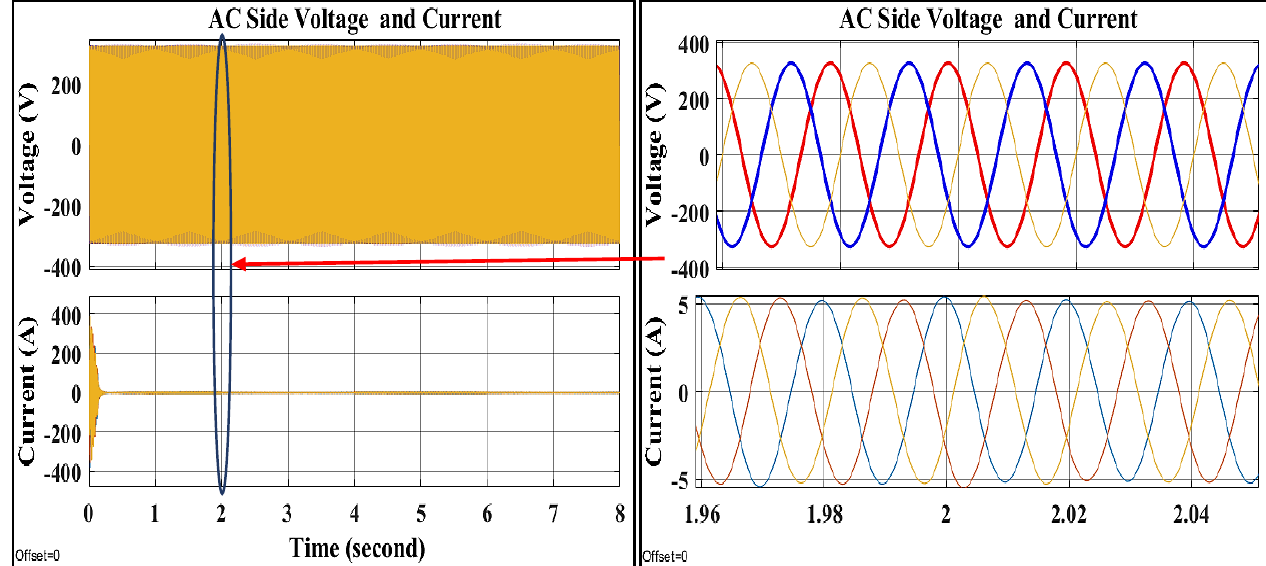
Figure 11. AC bus current and voltage 3ph signals (Scenario 1).